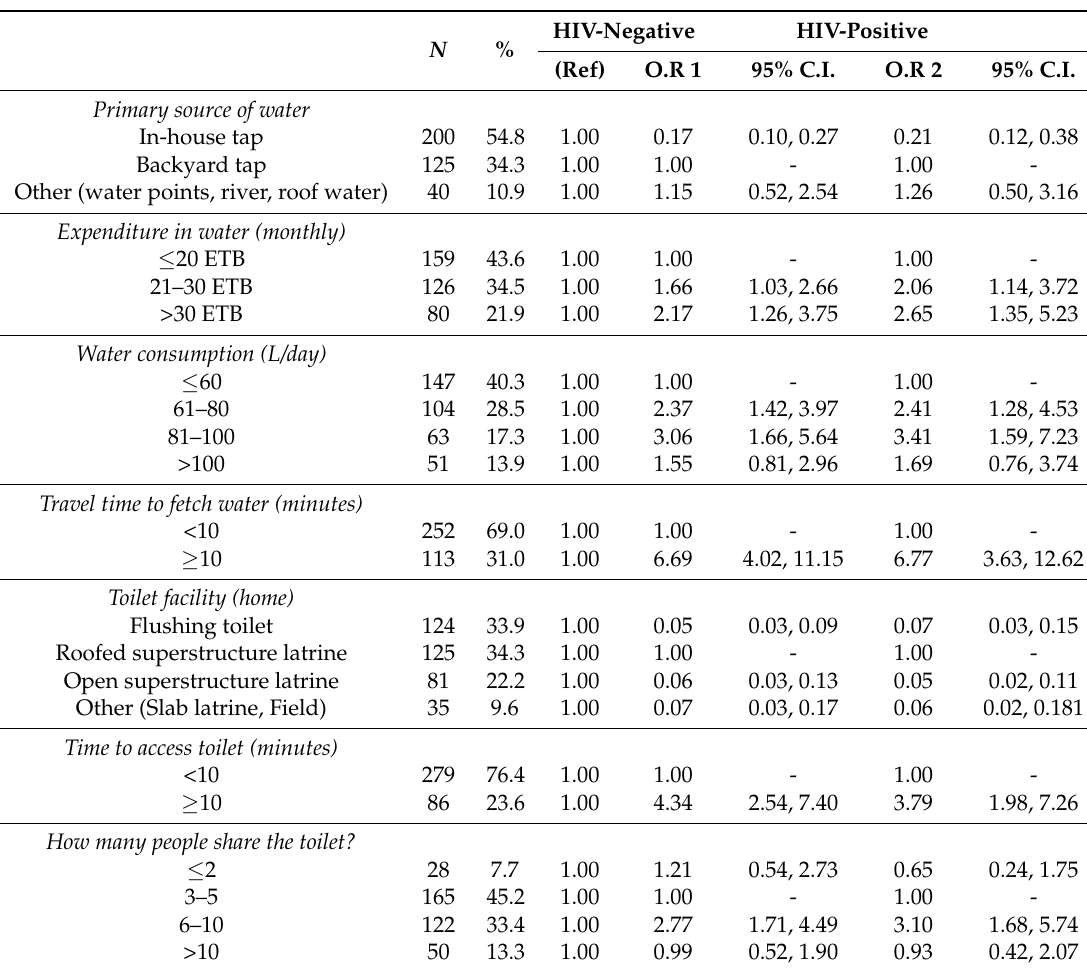
Table 1. Association between main features of the water and sanitation services among individuals in Wukro based on HIV status. Odds ratios (95% confidence intervals) from logistic regression models. ( N = 365